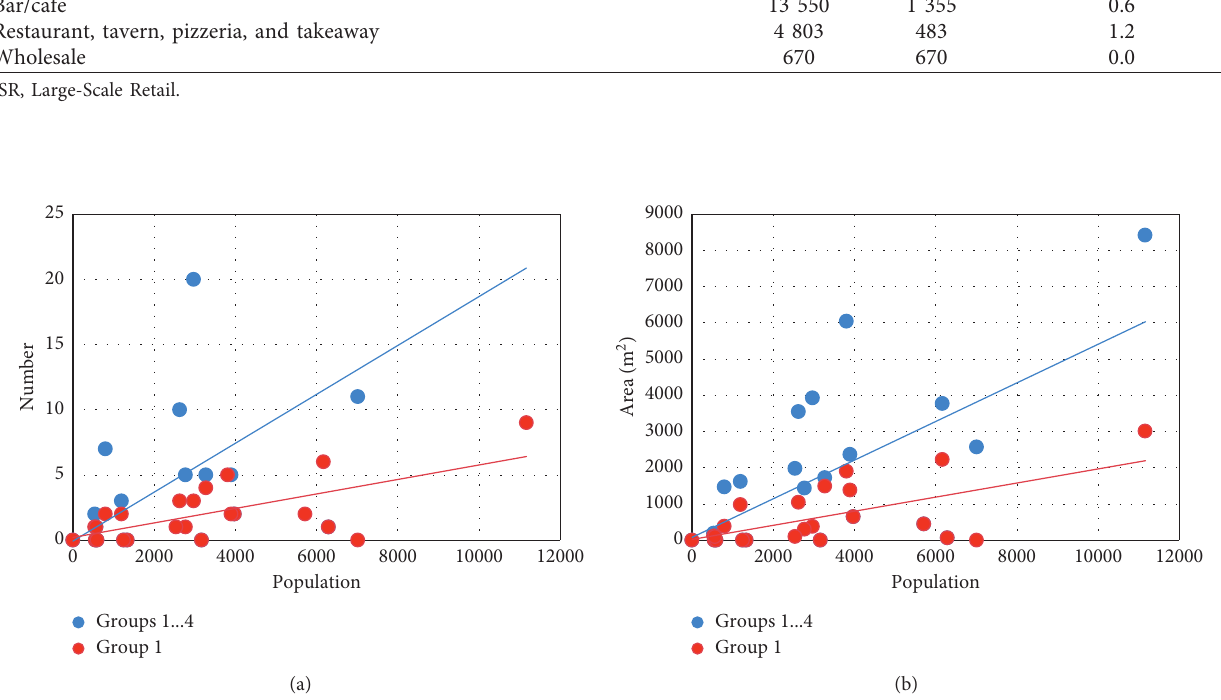
Figure 3: Number (a) and surface (b) of commercial activities versus population. Commercial activities of group 1 and of all groups 1, 2, 3, and 4.